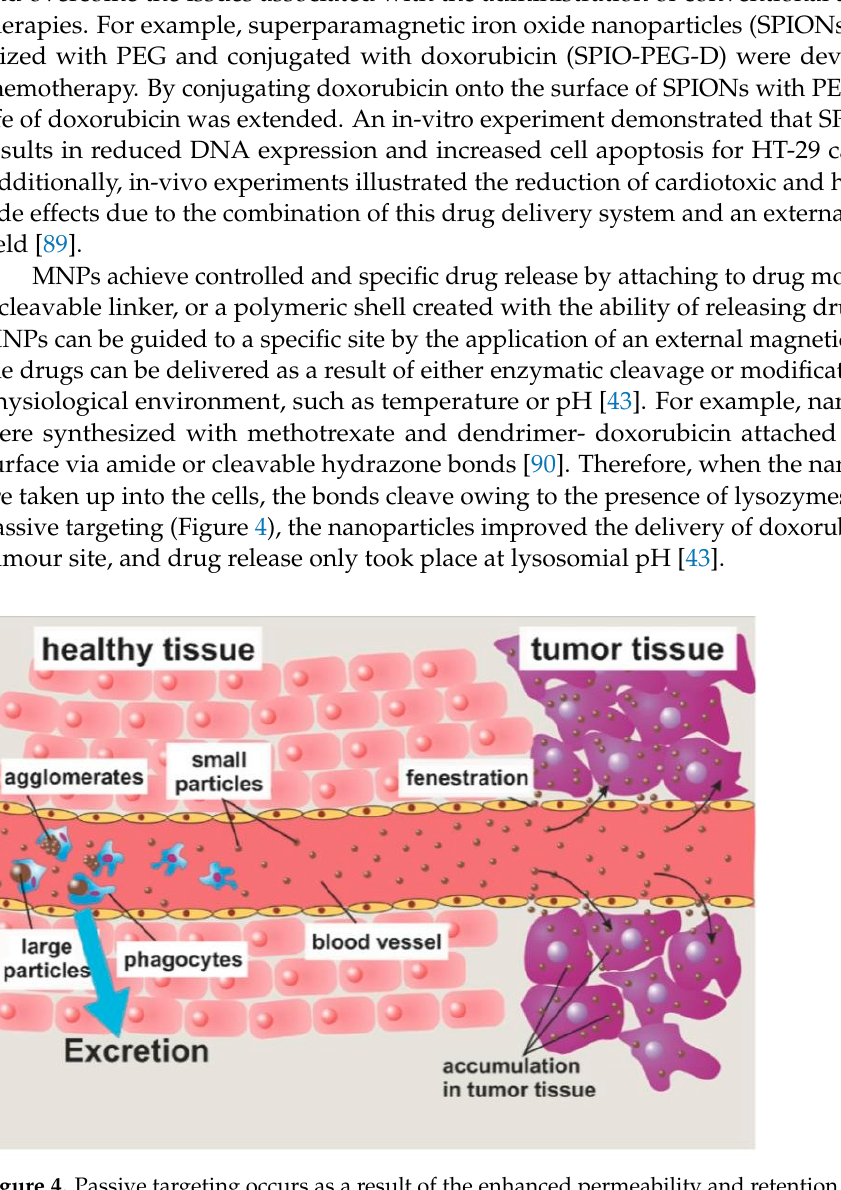
Figure 4. Passive targeting occurs as a result of the enhanced permeability and retention (EPR) effect. Large particles are engulfed by phagocytes, whilst small particles proceed to the target. The EPR effect allows the MNPs to accumulate within the target tumour [33].